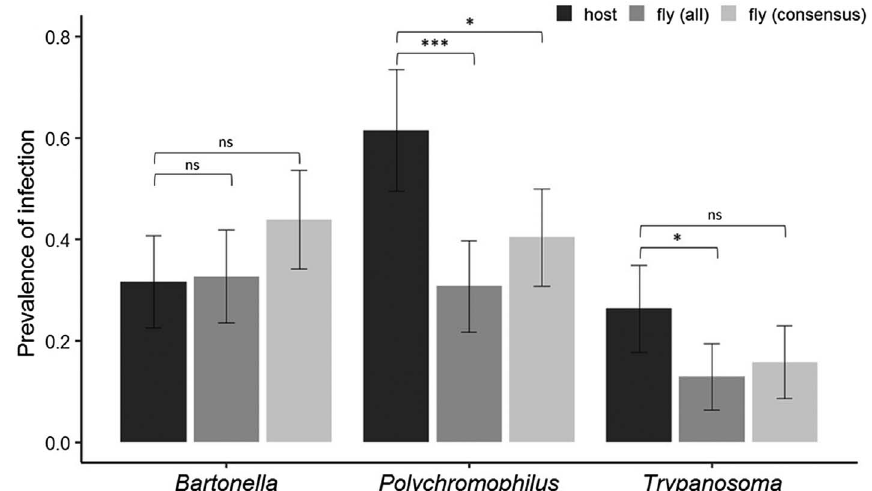
Figure 3. Comparison of detected microorganism prevalence (prevalence of infection) between bats and bat fl ies. Different bars represent hosts (black), all bat fl ies (dark grey), and consensus fl y results, meaning that at least one infected fl y individual was present on the host (light